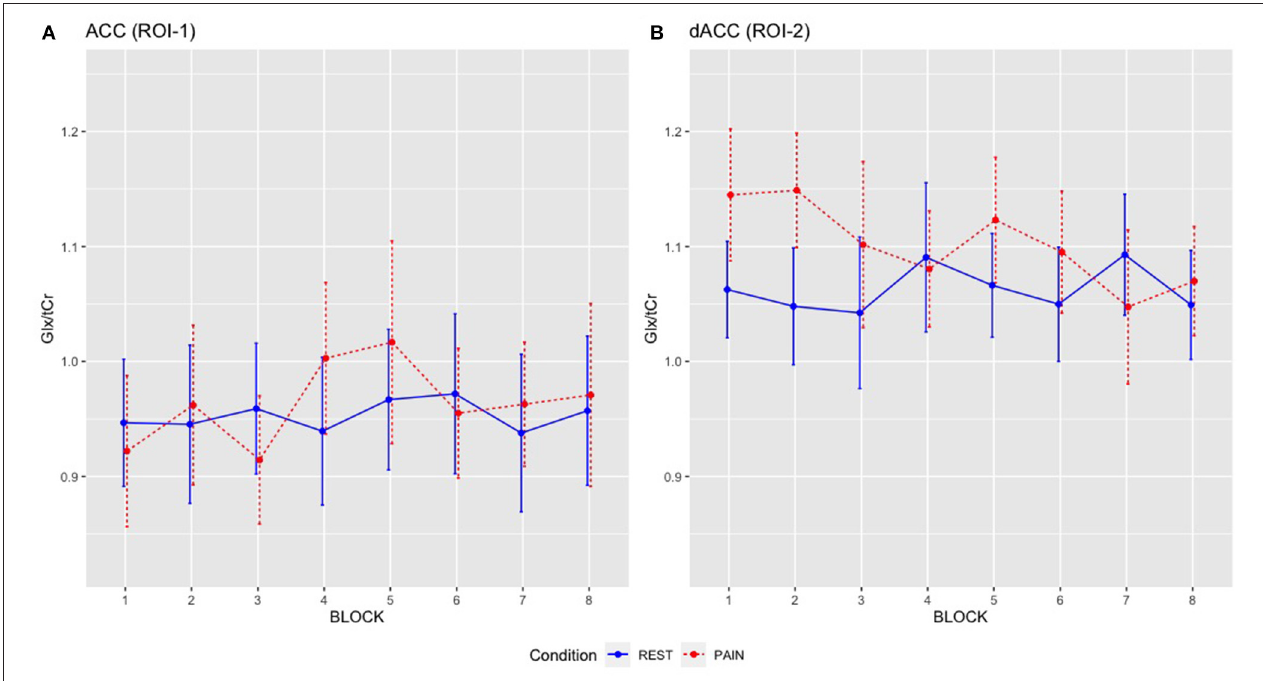
FIGURE 5 | Mean Glx/tCr for individual REST and PAIN blocks across scanning sessions: (A) ACC Glx/tCr, (B) dACC Glx/tCr. REST condition is shown in blue solid line and PAIN condition is shown in red dashed line. Error bars represent the 95% CI.